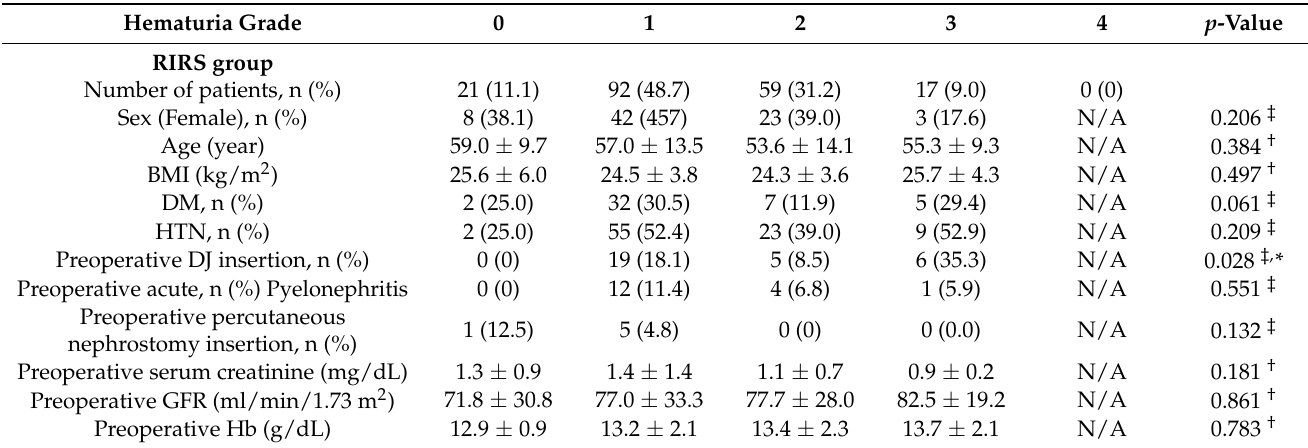
Table 2. Patient characteristics, clinical parameters, and complication rates of each grade